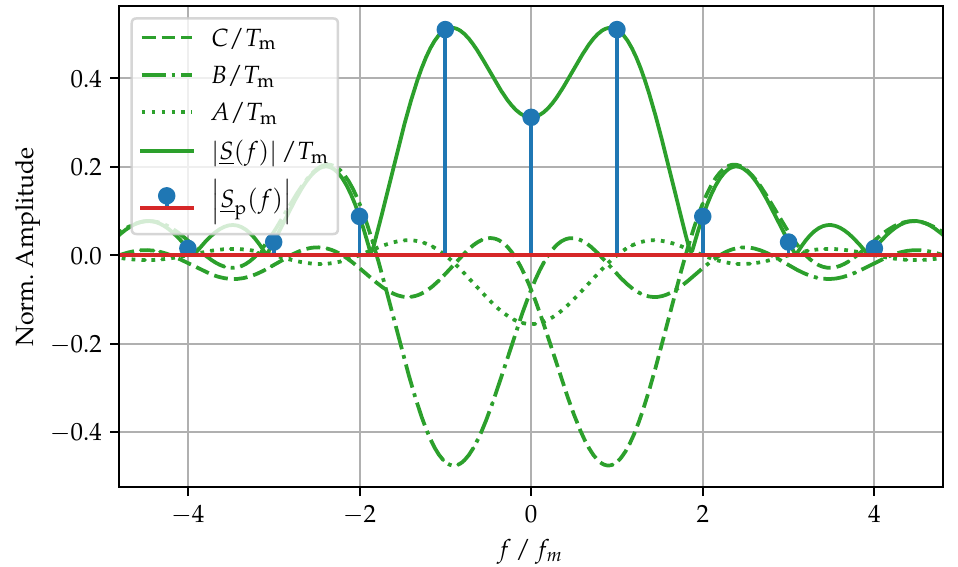
Figure 4. Amplitude spectrum of MZM output signal with φ 0 = 0.8 π and φ m = 1.2 π and the summands of S ( f ) : DC part A , left shifted sinc function B , and right shifted sinc function C